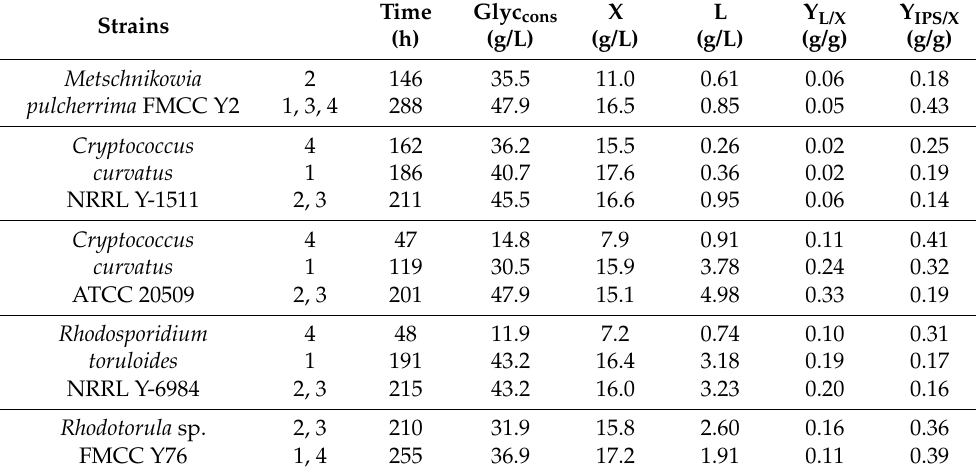
Table 1. Quantitative data of Metschnikowia pulcherrima , Rhodotorula sp., Rhodosporidium toruloides and Cryptococcus curvatus strains (a total of 5 strains) deriving from kinetics on crude glycerol, in nitrogen-limited shake-flask cultures, with initial glycerol (Glyc 0 ) concentration ≈ 50 g/L. Four different points in the fermentations are represented: (point 1) when the maximum quantity of DCW (X, g/L) was observed; (point 2) when the maximum quantity of lipid per DCW (Y L/X , g/g) was observed; (point 3) when the maximum quantity of absolute lipid value (L, g/L) was observed; (point 4) when the maximum quantity of intra-cellular polysaccharides per DCW (Y IPS/X , g/g) was observed. Fermentation time (h) and glycerol consumed (Glyc cons , g/L) are also depicted for all the above-mentioned fermentation points. Culture condition: growth on 250-mL conical flasks at 180 ± 5 rpm, initial pH = 6.0 ± 0.1, culture pH ranging between 5.2 and 5.8, incubation temperature T = 28 ◦ C. Each experimental point is the mean value of two measurements (SE < 15%).